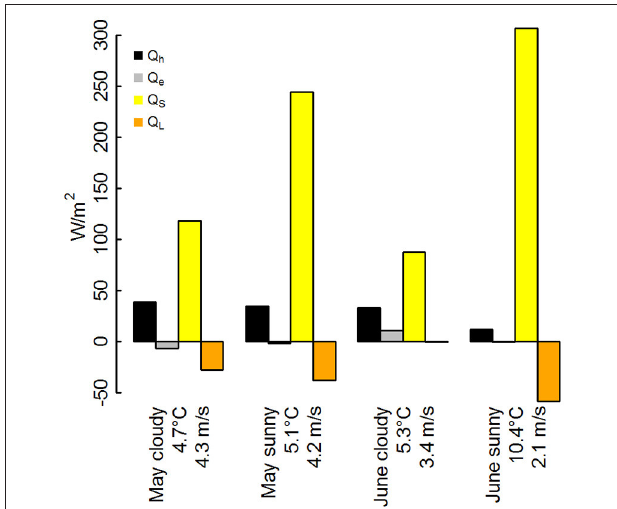
FIGURE 5 | Twelve hourly-mean of daytime energy fluxes (06:00a.m. − 06:00 p.m.) modeled with SNOWPACK for the Weissfluhjoch test site (Swiss Alps, 2560m ASL) for typical cloudy and sunny days in May and June. Air temperatures and wind velocities are mean values for the given time period of 12h. Q S is net shortwave radiation (yellow). Q L is net longwave radiation (orange). Black and gray colors indicate turbulent exchange of sensible (Q h ) and latent heat (Q e